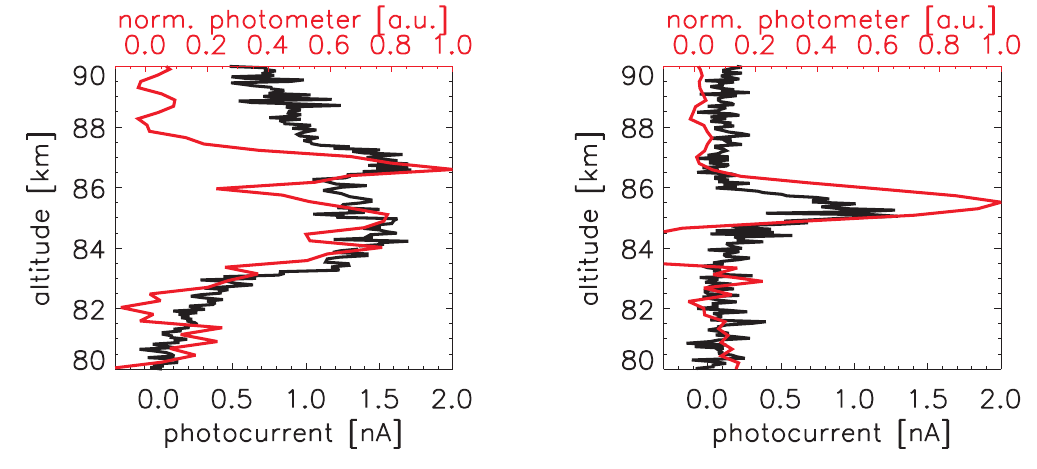
Fig. 5. Photoelectron currents recorded by the ECOMA-particle detector on upleg (left panel) and downleg (right panel) compared to photometer measurements indicating the presence of “visible” ice particles (red lines), i.e., ice particles with radii in excess of ∼ 20nm. Note that the photometer profiles shown here are derived by taking the vertical derivative of a signal which is the integral of the scattering from all particles and molecules along the line of sight of the instrument. E.g., as the instrument passes through the cloud from above (as is the case during the downleg, see right panel), this integral signal should steadily increase because more and more particles are along the line of sight (the rocket is spin-stabilized and the photometer is pointing upwards). Hence, the photometer signal is expected to show a continuous increase when moving through the cloud and the derivative should reveal the cloud as a pronounced layer of positive values only. On top of the vertical motion, however, the rocket is also spinning such that the photometer with a field of view at some angle to the rocket axis scans different horizontal parts of the cloud. If the cloud is strongly inhomogeneous, it may happen that the integral scattering signal could actually decrease during the rocket’s descent through the cloud because the photometer sees a dimmer patch at some horizontal location than at another location. In consequence, the differentiated brightness profile can turn negative as shown here at about 84km. This feature hence indicates pronounced inhomogeneities in the cloud layer. See Megner et al. (2009) for more